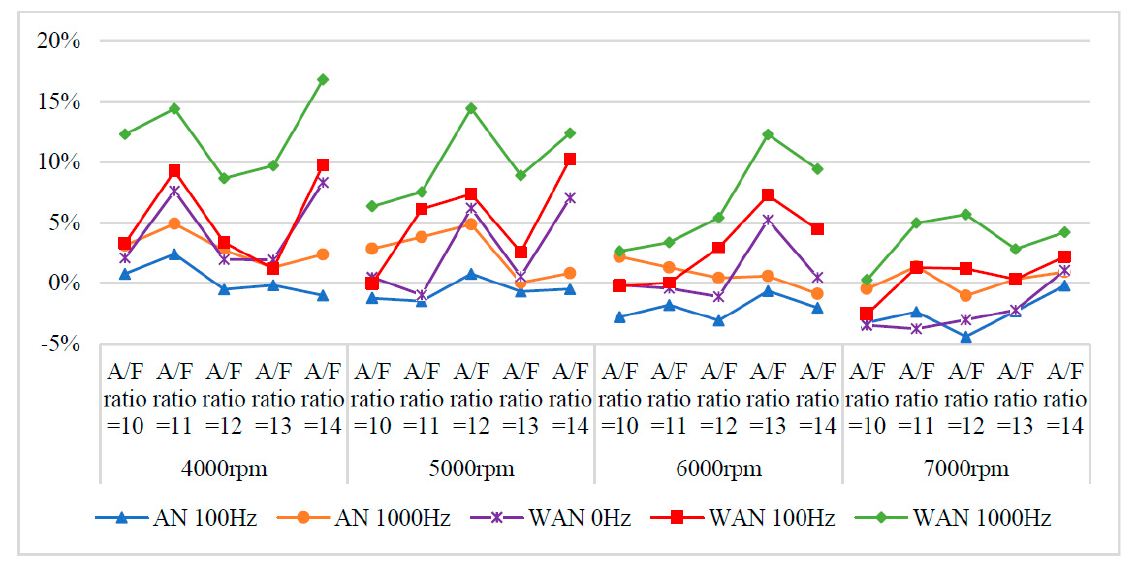
Figure 14. The NOx change rate of WAN and AN with different frequencies.